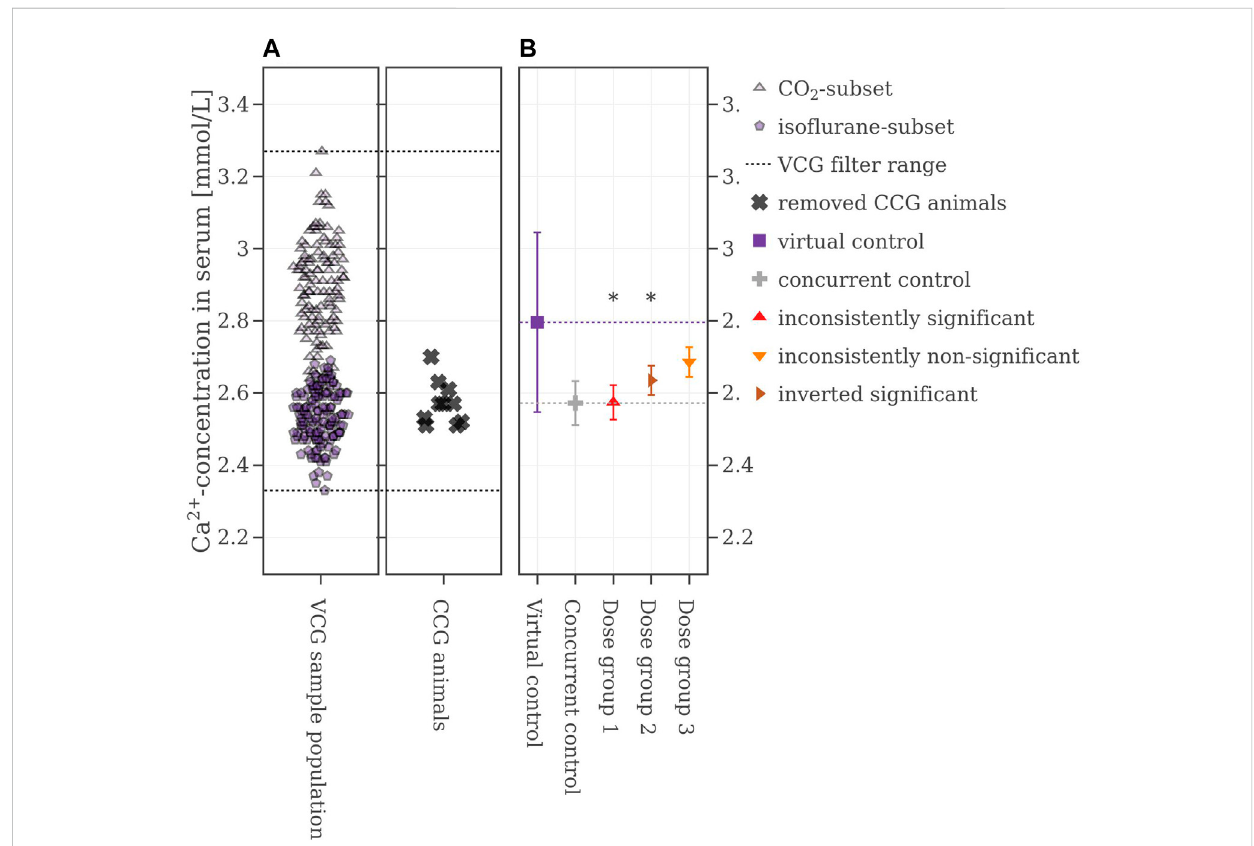
FIGURE 4 (A) Selection range of virtual control values and concurrent control values which are removed. (B) Mean values of the legacy study and the virtual control, colored with respect to whether the original statistical results were reproduced or not. If the mean difference between a dose group and the virtual control exceeded the Dunnett-critical distance, the group was marked with an asterisk.